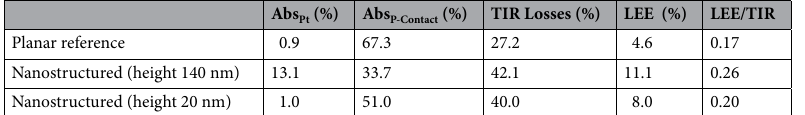
Table 2. The absorption in the Pt electrode (Abs Pt ) and p-contact region (Abs P-Contact ), the light emission lost due to total internal reflection (TIR Losses), the light extraction efficiency (LEE) and ratio of LEE to TIR losses for the planar reference and nanostructured devices with 300 nm pitch and 150 nm diameter